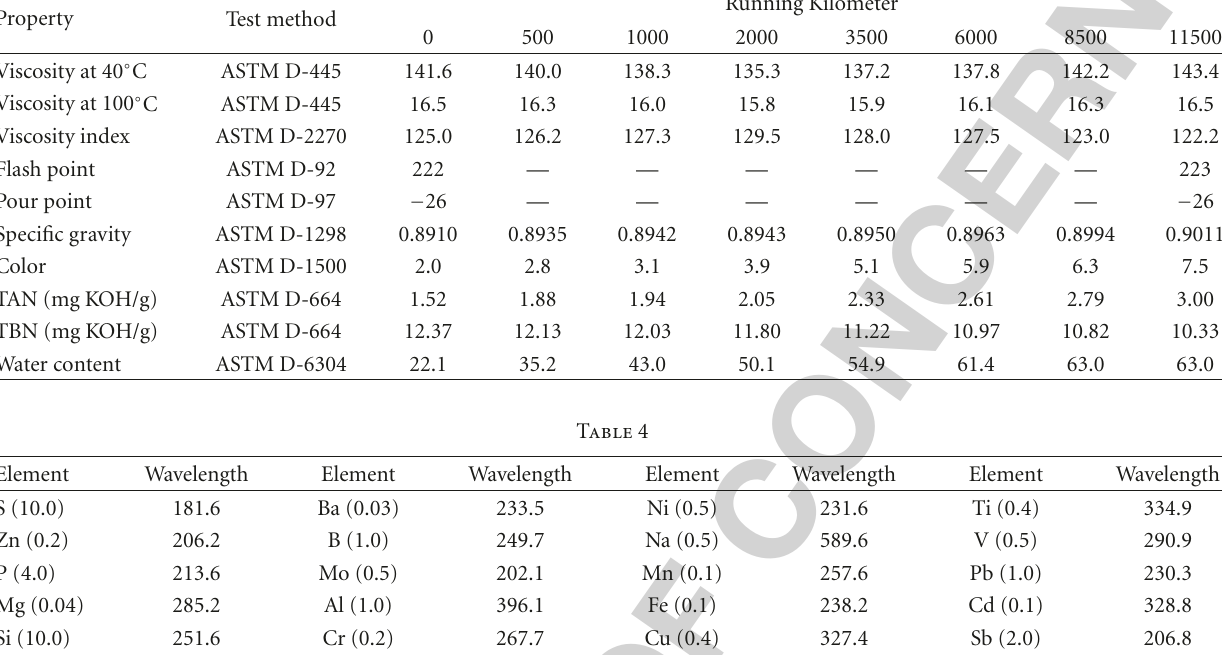
Table 3: Physical properties at di ff erent running kilometer.